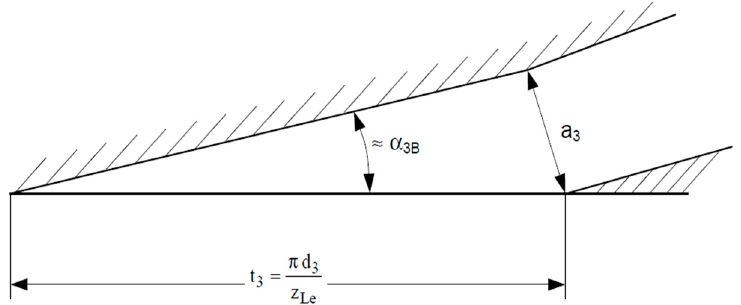
Figure 3. Evaluation of the outflow angle, α 3 , from throat height, a 3 , and pitch, t 3